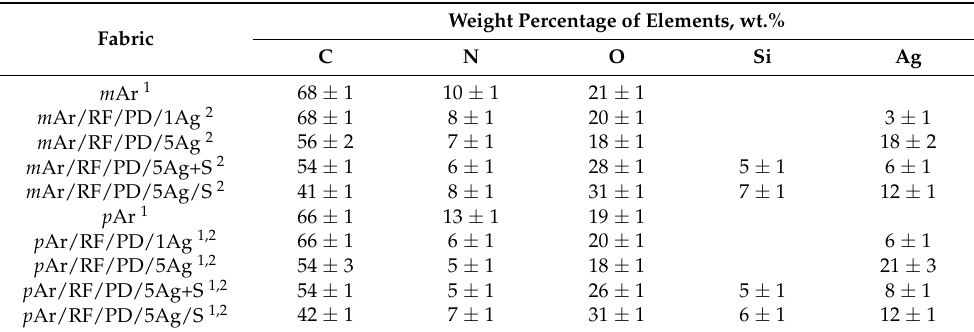
Table 4. The mean values of the weight percentages of the elements with standard deviations for unmodified and modified m Ar and p Ar fabrics. Weight Percentage of Elements, wt.% Fabric